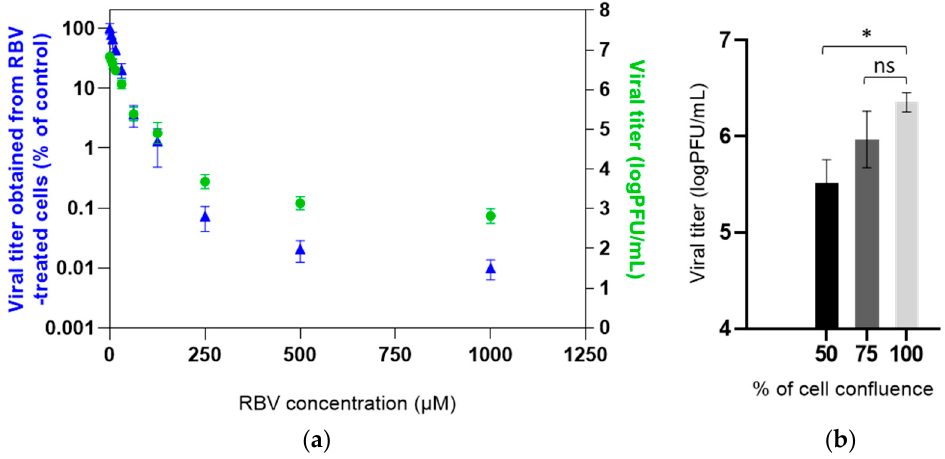
Figure 2. Dose-dependent antiviral effect of RBV against MuVi-C: ( a ) Vero cells were treated with different concentrations of RBV or mock-treated, infected with MuVi-C at MOI 0.001. Then, media with or without RBV were added for an additional 72 h. Titres in supernatants were determined using the plaque assay; titres (logPFU/mL) are plotted on the right y axis, and the titre (number of plaques) of virus obtained from RBV-treated cells as a percentage of the virus titre obtained from untreated, control cells is given on the left y axis. ( b ) Vero cells were seeded to obtain 50%, 75% and 100% confluence on the day of infection, infected with MuVi-C at MOI 0.001. Supernatants were collected after 72 h and titres in supernatants were determined using the plaque assay. Mean and standard deviations are shown from 3 biological replicates. Statistical significance between groups was determined using Kruskal–Wallis one-way ANOVA (* p < 0.05; ns,